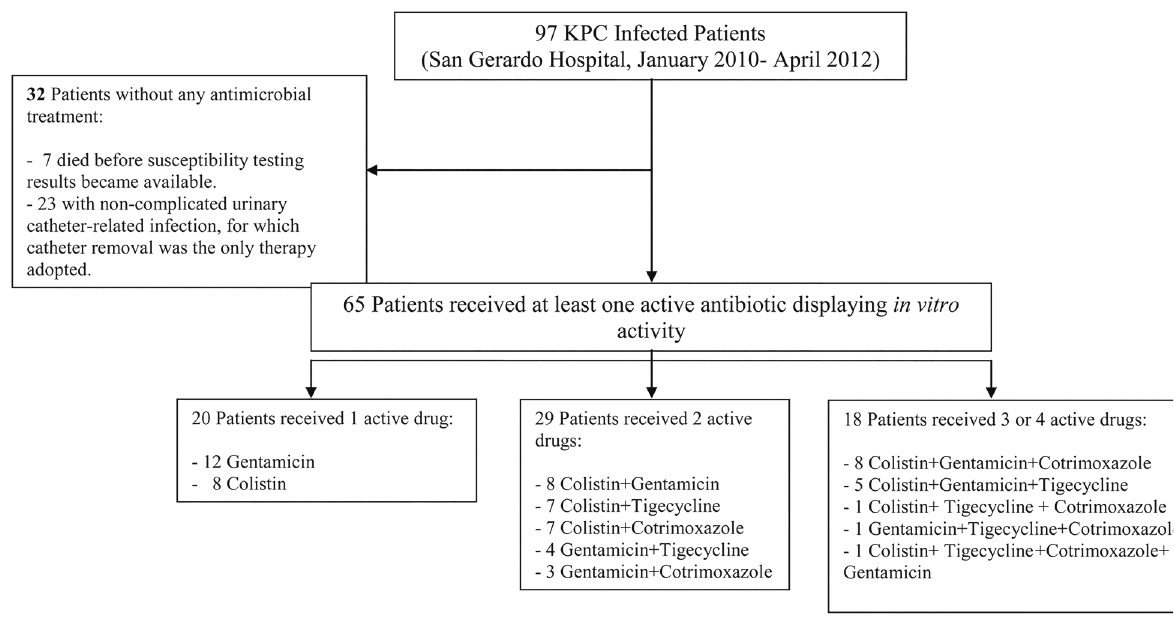
Figure 3. Antimicrobial treatment profile for the 97 patients